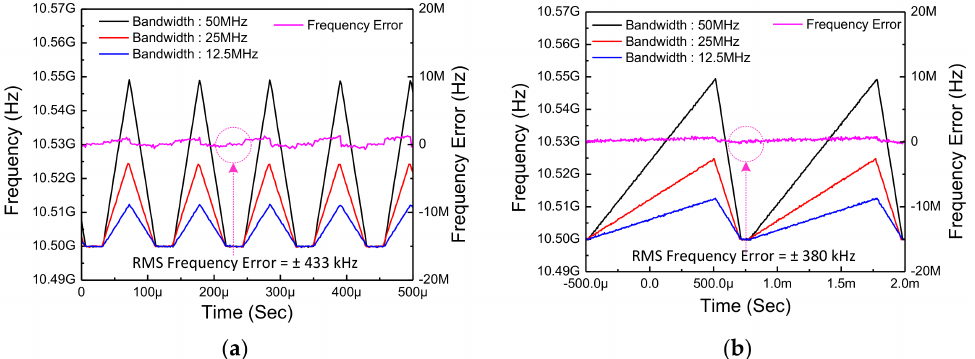
Figure 22. The measured FMCW chirp waveform and root-mean square (FMS) frequency error in time domain according to several conditions with a chirp time of ( a ) 100 µ s and ( b ) 1 ms, according to modulation bandwidth of 12.5 MHz, 25 MHz, and 50 MHz.